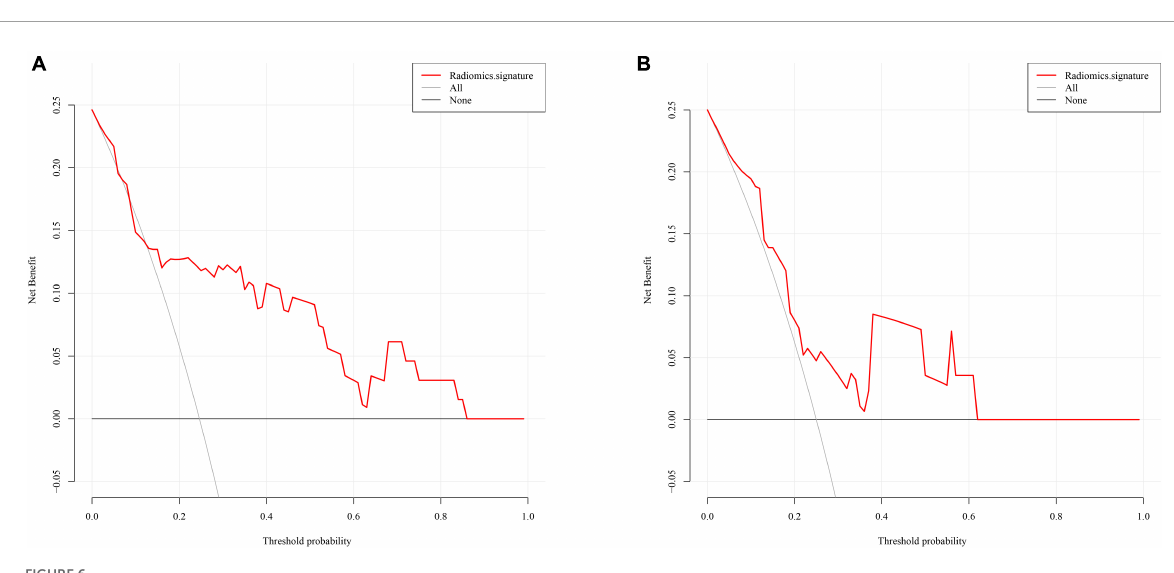
interleukin-6, activin-A, and tumor necrosis factor-alpha